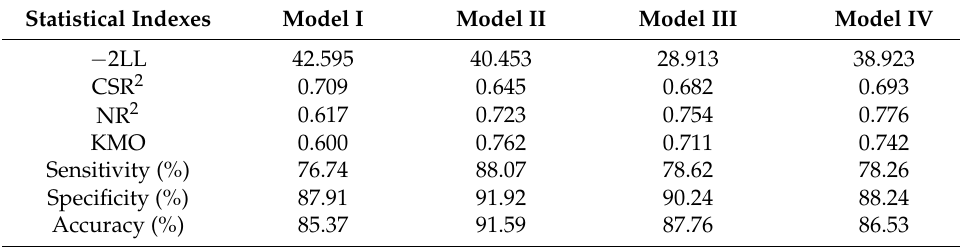
Table 12. Statistical indexes and AUC value of the hybrid model.